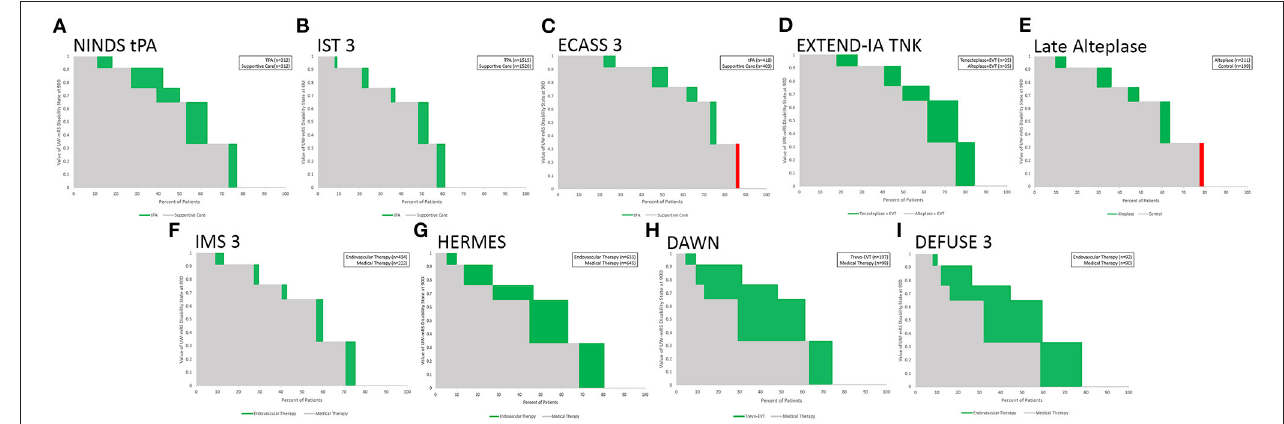
FIGURE 3 | Utility Staircase charts showing nine trials and meta-analyses of reperfusion therapy for acute ischemic stroke. Top row: intravenous fibrinolysis trials, including: (A) IV tPA under 3h; (B) IV tPA up to 6h; (C) IV tPA in 3–4.5h; (D) IV tenecteplase vs IV tPA in large vessel occlusion patients up to 4.5h, and (E) IV alteplase in imaging selected patients after 4.5h. Bottom row: endovascular reperfusion trials, including: (F) early generation techniques; (G) second generation mechanical thrombectomy largely in early time windows (H) second generation mechanical thrombectomy with imaging selection 6–24h after onset, and (I) second generation mechanical thrombectomy with broader imaging selection 6–16h after onset.